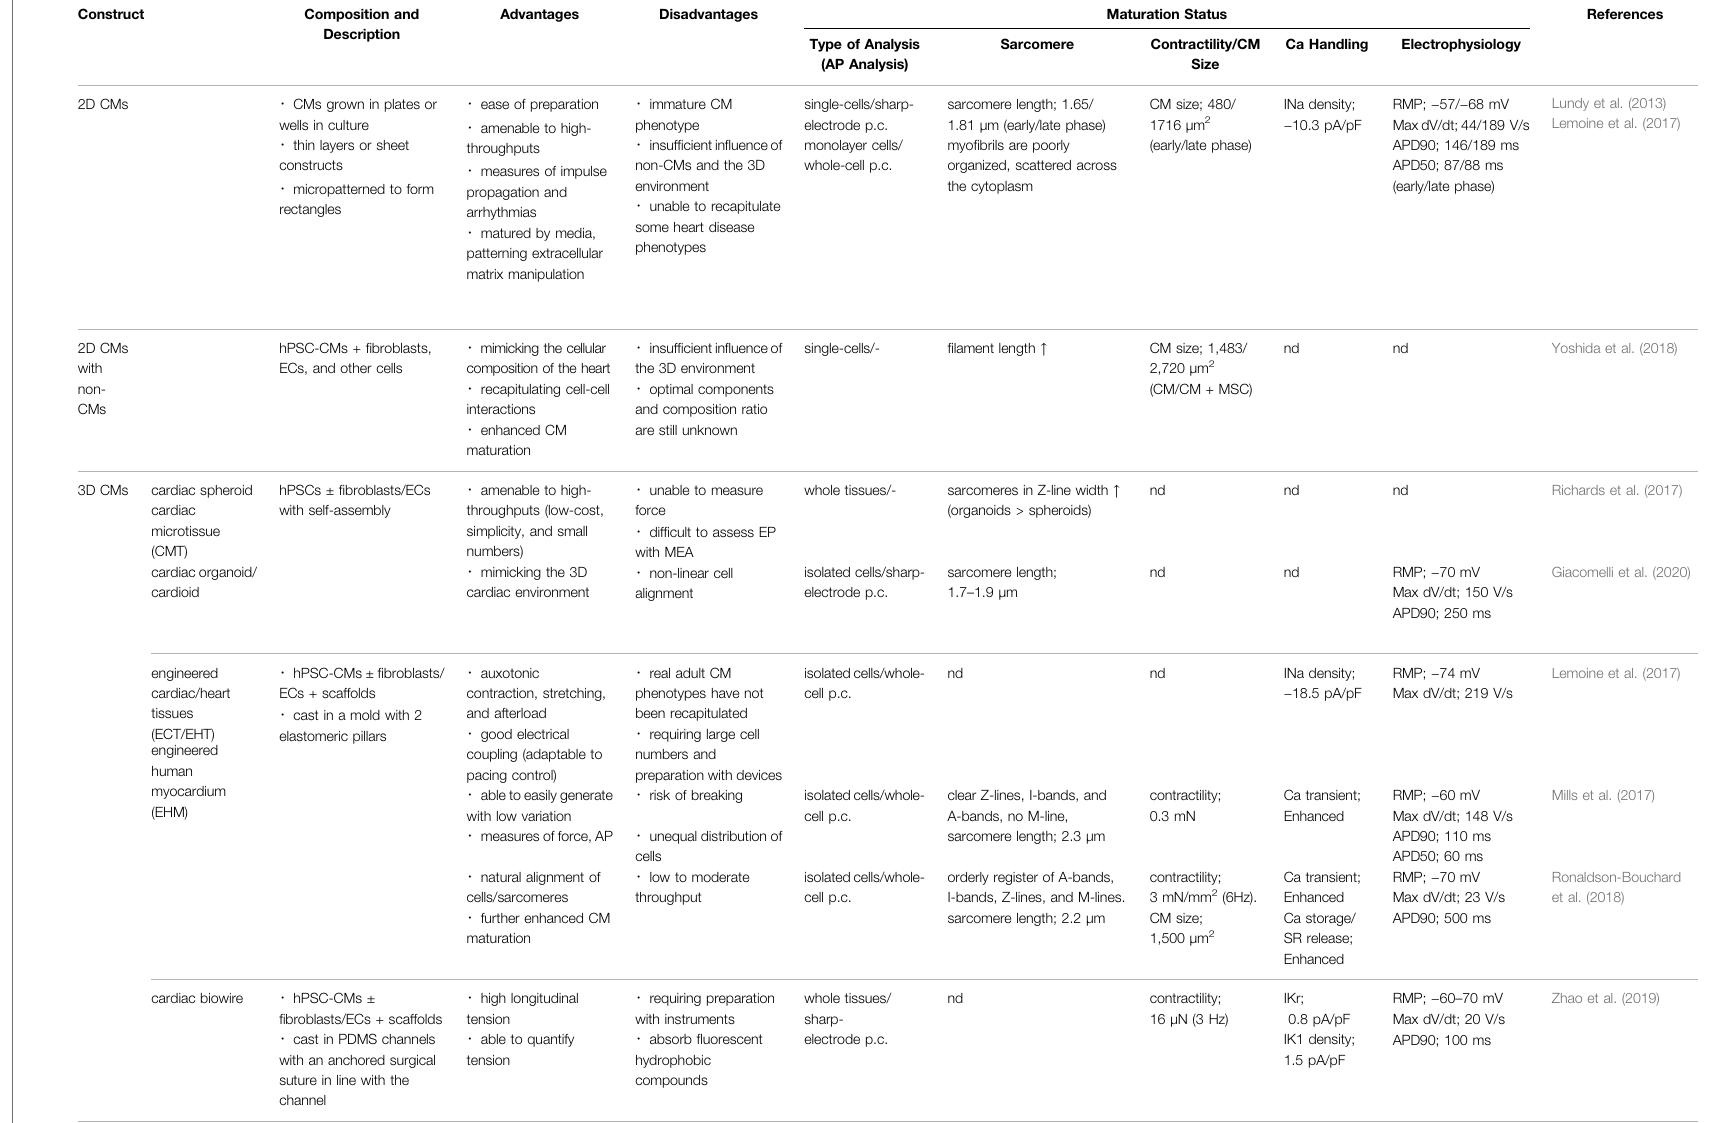
TABLE 1 | Features of human heart models in vitro